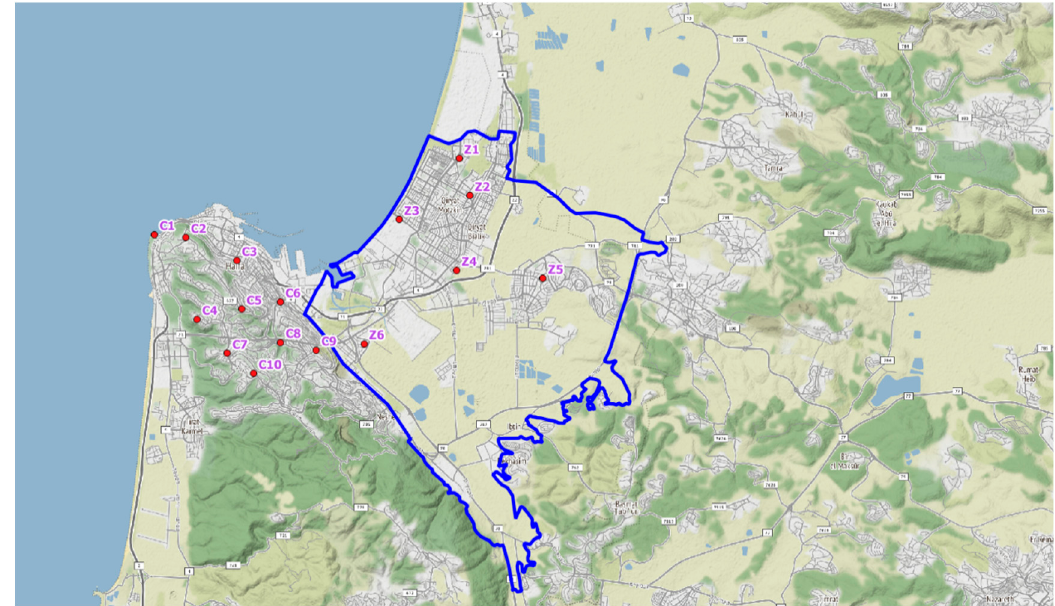
Figure 1. The weather stations in the Zevulun valley area (with Z prefix) and Mount Carmel (with C prefix). The blue border signifies the borders of southern Zevulun valley, which contains the Haifa Bay area.